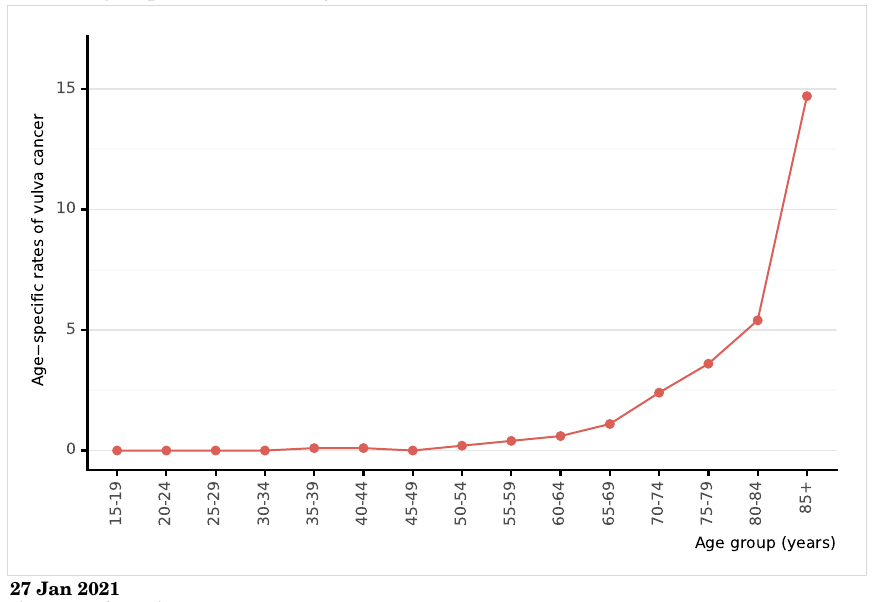
Figure 23: Age-specific mortality rates of vulva cancer in Peru (estimates for 2020)